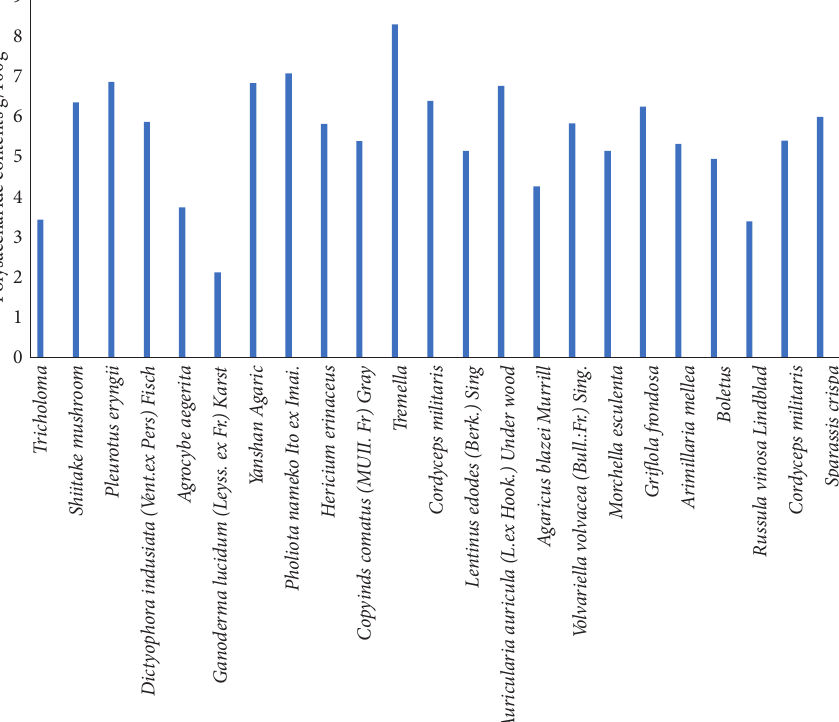
Figure 6: Polysaccharide contents of 23 kinds of edible fungi.